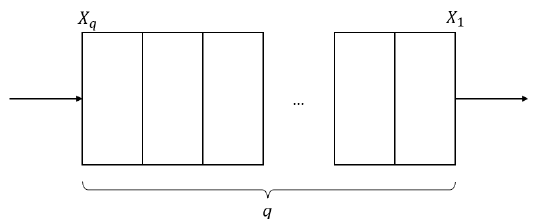
Figure 1. General representation of neural network